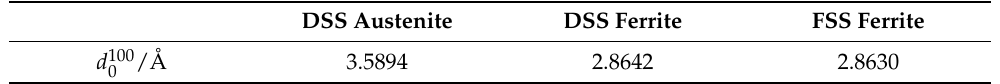
Table 2. Applied reference lattice spacings d 100 . 0 DSS Austenite DSS Ferrite FSS Ferrite d 100 /Å 3.5894 2.8642 2.8630 0